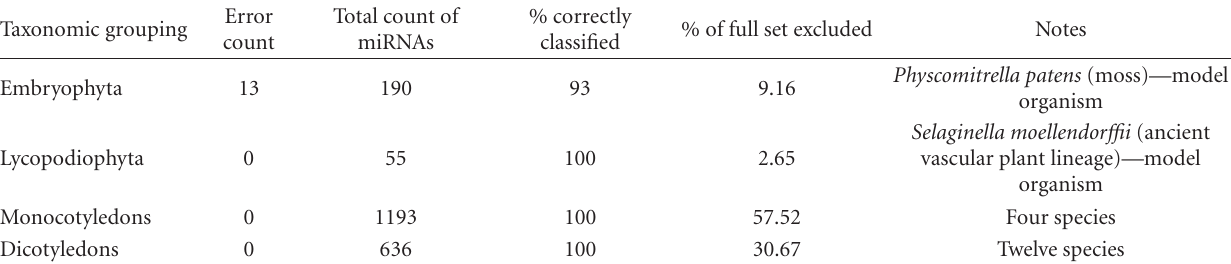
Table 8: Results from exclusion of each of the four taxonomic groups.